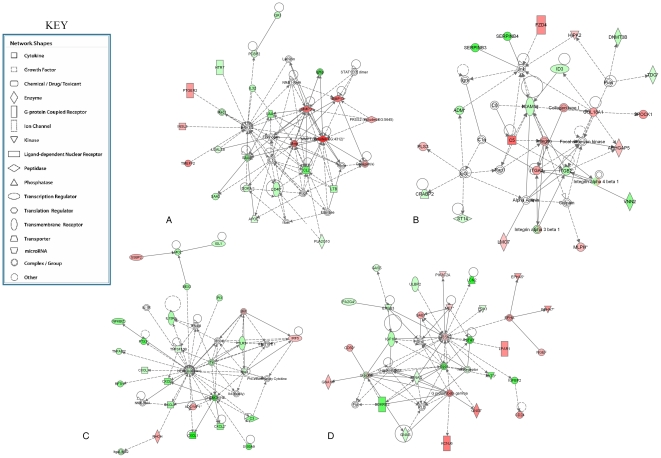
Gene Ontology (GO) enrichment pathway analysis.Analysis of genes modulated following RPL19 knockdown identified five interlinked pathways principally affected (Supporting Information Table S5). Four of these include genes encoding MMP enzymes (A); the ICAM1-integrin complex (B); the NFκB complex (C) and PI3K regulation (D). This analysis confirmed several genes modulated by down-regulated expression of RPL19 to be interconnected, emphasizing the numerous pathways for cross-talk between apparently distinct biological processes.